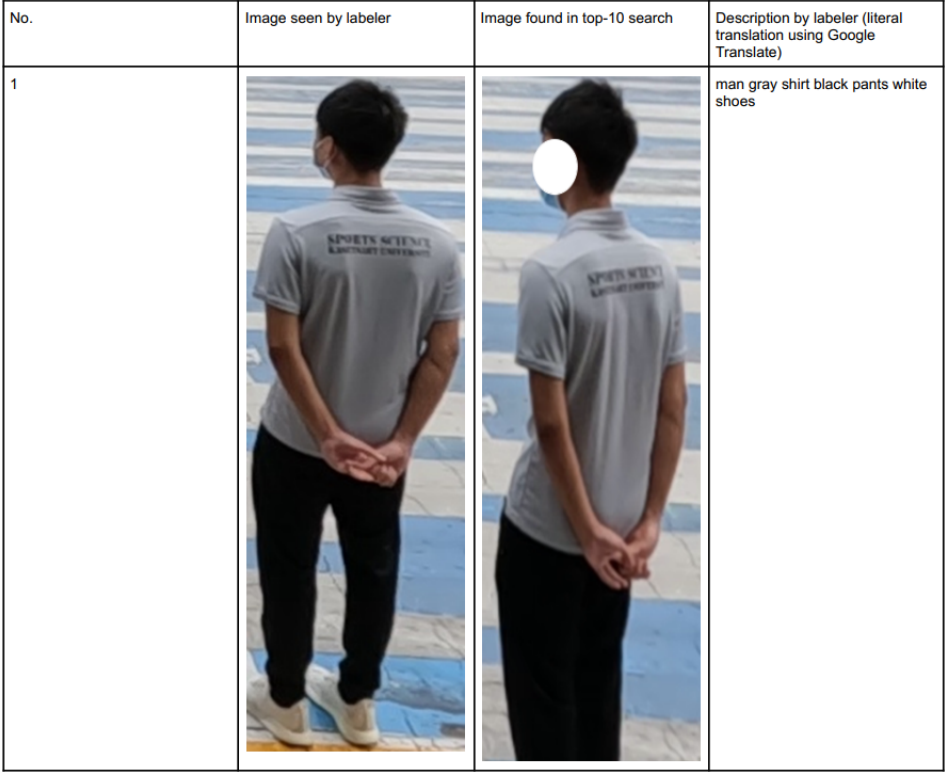
Figure 7. One example comparing the image that the labeler sees, and the matched image found by the search using the labeler’s description as the query text. Note that the English description is obtained by a literal translation using Google Translate, which sometimes is not exactly correct compared to the original description in Thai. The matched image was chosen from the top-10 result by manual inspection. The full table can be found in the supplementary data at https://bit.ly/3GcAGTn.